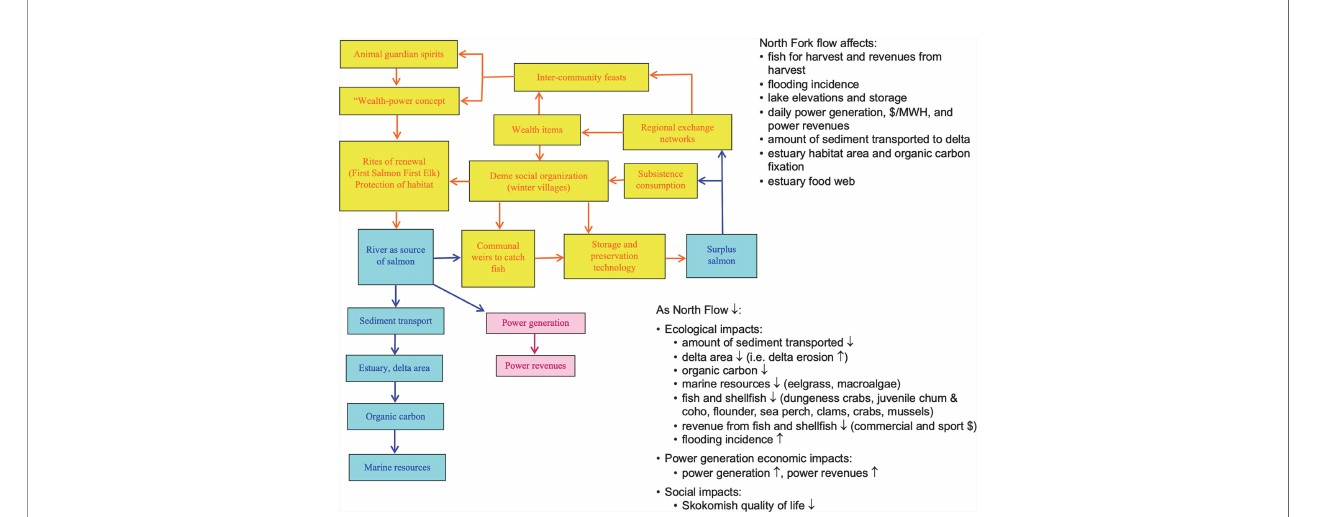
FIGURE 7 | Model of 18 Impacts (for details on the meaning of the color codes see Lansing, Lansing et al.,